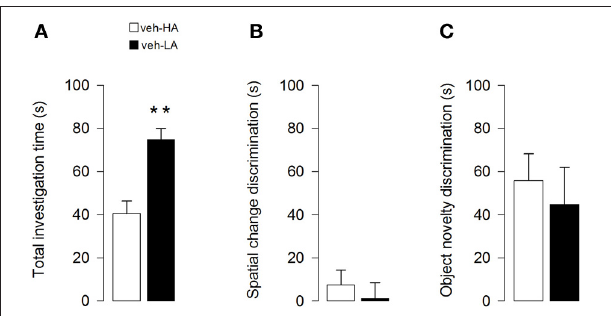
FIGURE 3 | Effects induced by different arousal conditions on object investigation and cognitive performances of vehicle-treated rats. Total investigation time of all objects through sessions (A) spatial change discrimination (B) and object novelty discrimination (C) .** P < 0 . 01. Data are expressed as mean ± SEM. (High Arousal: HA n = 10; Low Arousal: LA n = 15).